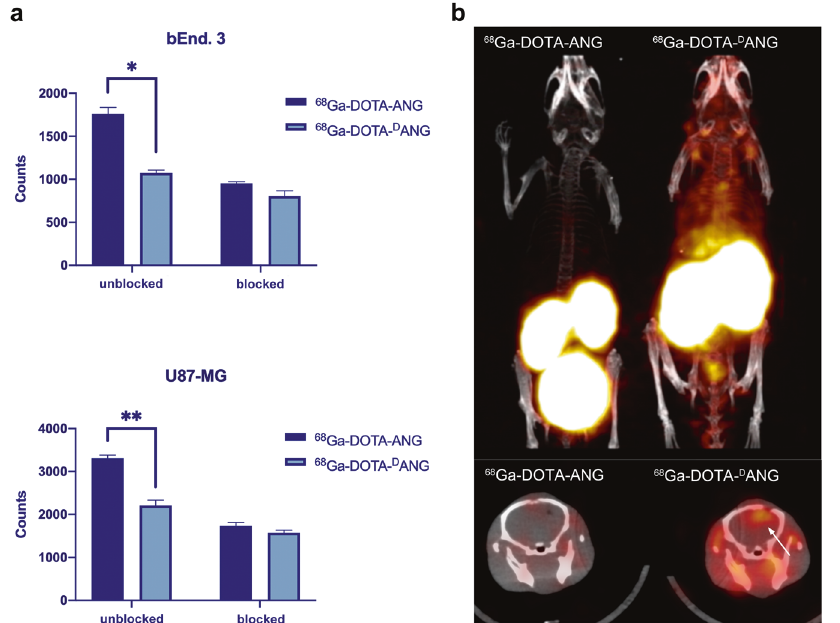
Fig. 4 a Radioactivity counts of bEnd.3 and U87-MG cell lysates; b PET/CT images of tumour-bearing mice The upper image is a scintigraph of the in vivo distribution of probes, and the lower image is a fused presentation to show the aggregation of probes in the brain. Data from at least three independent experiments are shown as the means ± SEMs, n = 3, * p , ** p <